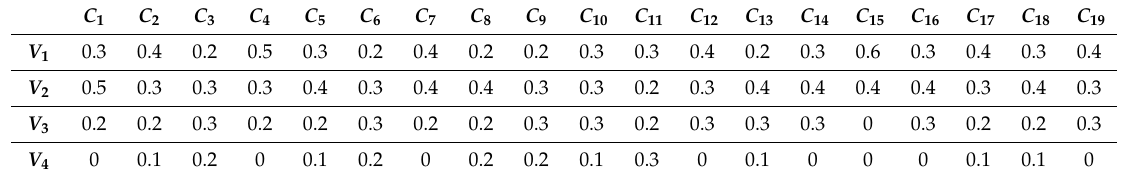
Table 10. Fuzzy evaluation matrix of the